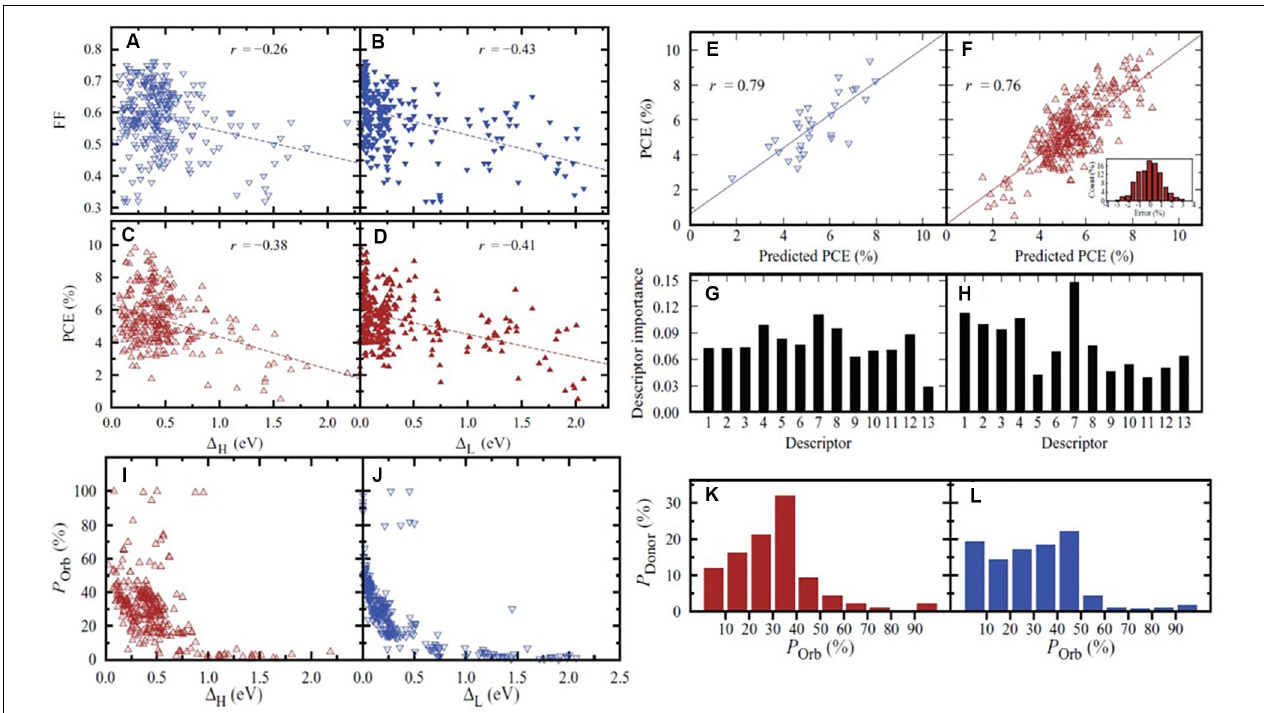
FIGURE 5 | (A,C) Correlations of FF and PCE versus (cid:49) H. (B,D) Correlations of FF and PCE versus (cid:49) L. Theoretically predicted versus experimental PCE for the testing set (30 molecules) (E) and all data points using the leave one out cross validation technique (F) for the GB model. It describes the importance of descriptors for GB (G) and RF (H) models. (I) and LUMO (J) to the most important electronic transition versus (cid:49) H and (cid:49) L, respectively. Percentage of donor molecules (PDonor) versus POrb in cases of occupied (K) and unoccupied (L) orbitals are depicted. Reproduced from Sahu et al. (2018) with permission from Copyright WILEY-VCH Verlag GmbH & Co., KGaA,